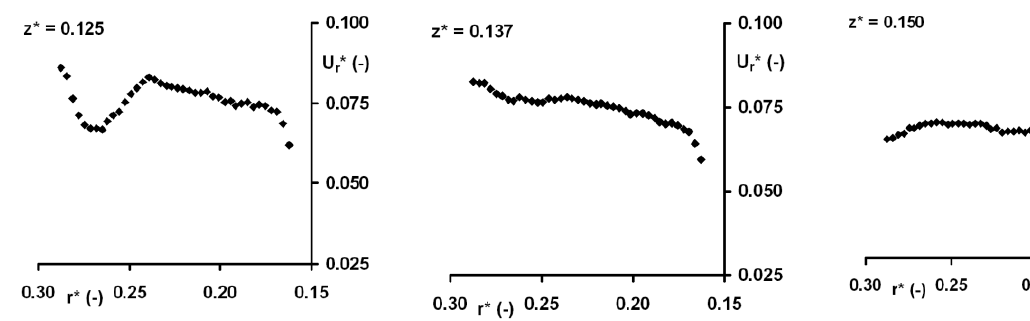
Fig. 6. Dimensionless radial mean velocity profiles ) / ( N D U